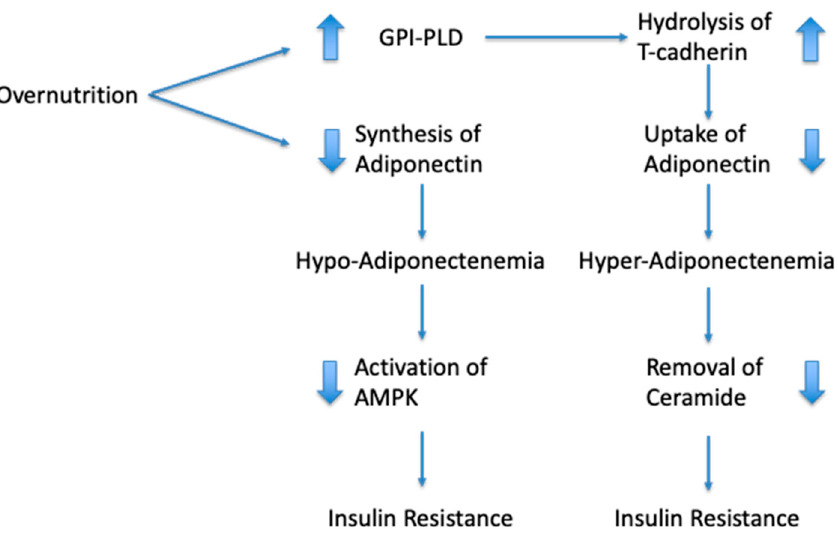
Figure 1. Schematic representation of the association between overnutrition and circulating levels of adiponectin. Overnutrition provokes adipocyte hypertrophy, which gives rise to hypoxia and a reduction in adiponectin synthesis. Dysfunctional adiponectin signaling causes a reduction in